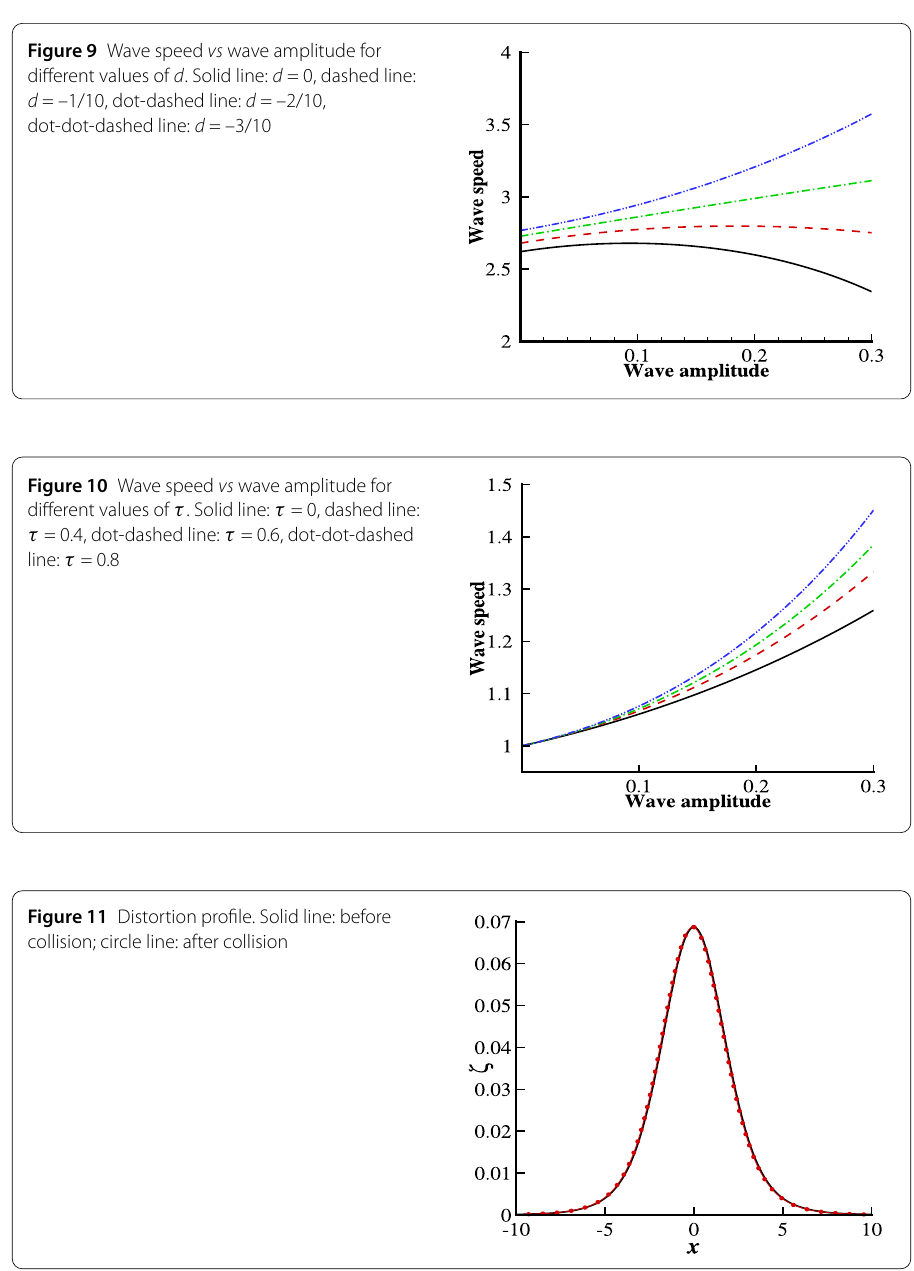
Figure 9 Wave speed vs wave amplitude for different values of d . Solid line: d = 0, dashed line: d = –1/10, dot-dashed line: d = –2/10, dot-dot-dashed line: d = –3/10